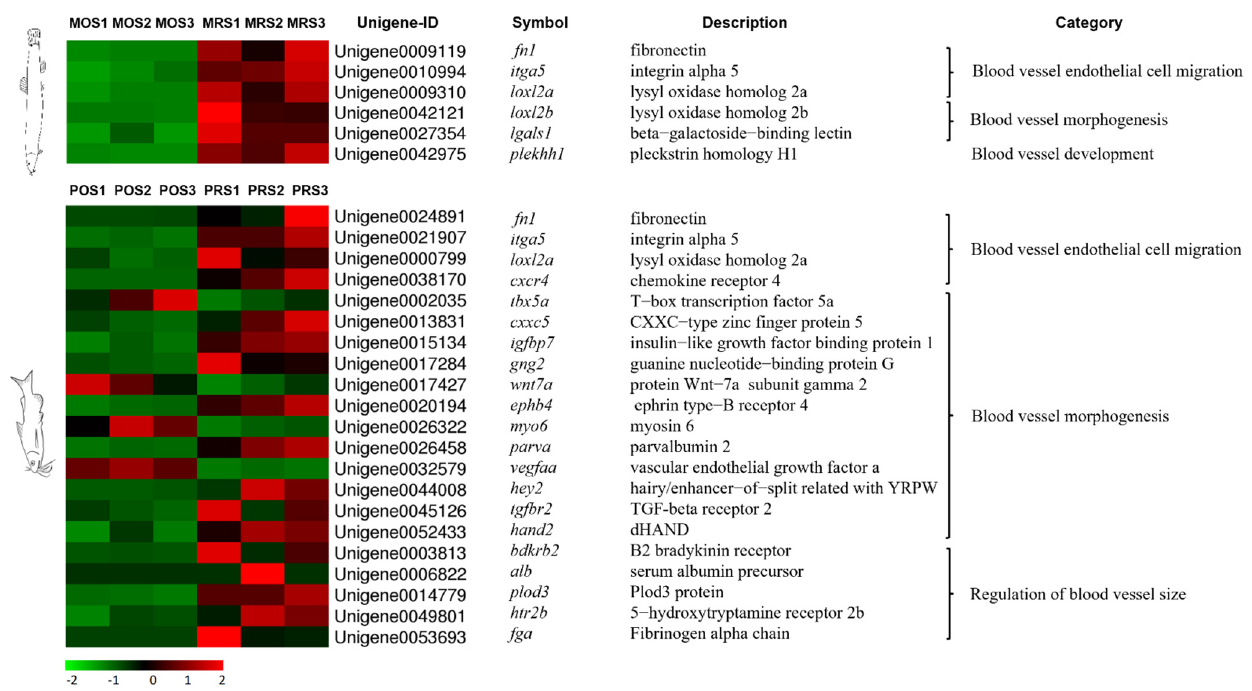
Figure 5. Expression profiles of cutaneous air-breathing formation related genes in regenerated skin of loach. OS: original skin; RS3: regenerated skin of the 3rd day after cutaneous incision (daci). RS6: regenerated skin of the 6th daci. RS9: re- generated skin of the 9th daci. RS12: regenerated skin of the 12th daci. * indicates significant difference of gene express